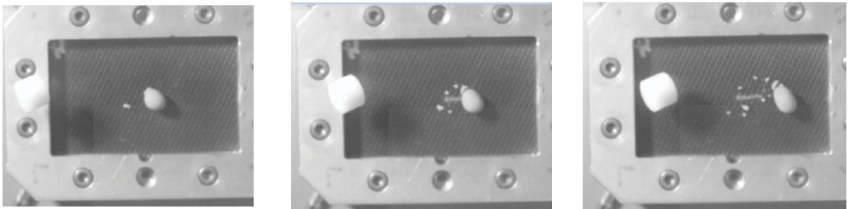
Figure 22. Sample 7, CF + Kevlar, 3.4 J, smooth gravel, showing the initial ( left ), intermediate ( centre ), and gravel detachment stages ( right ).